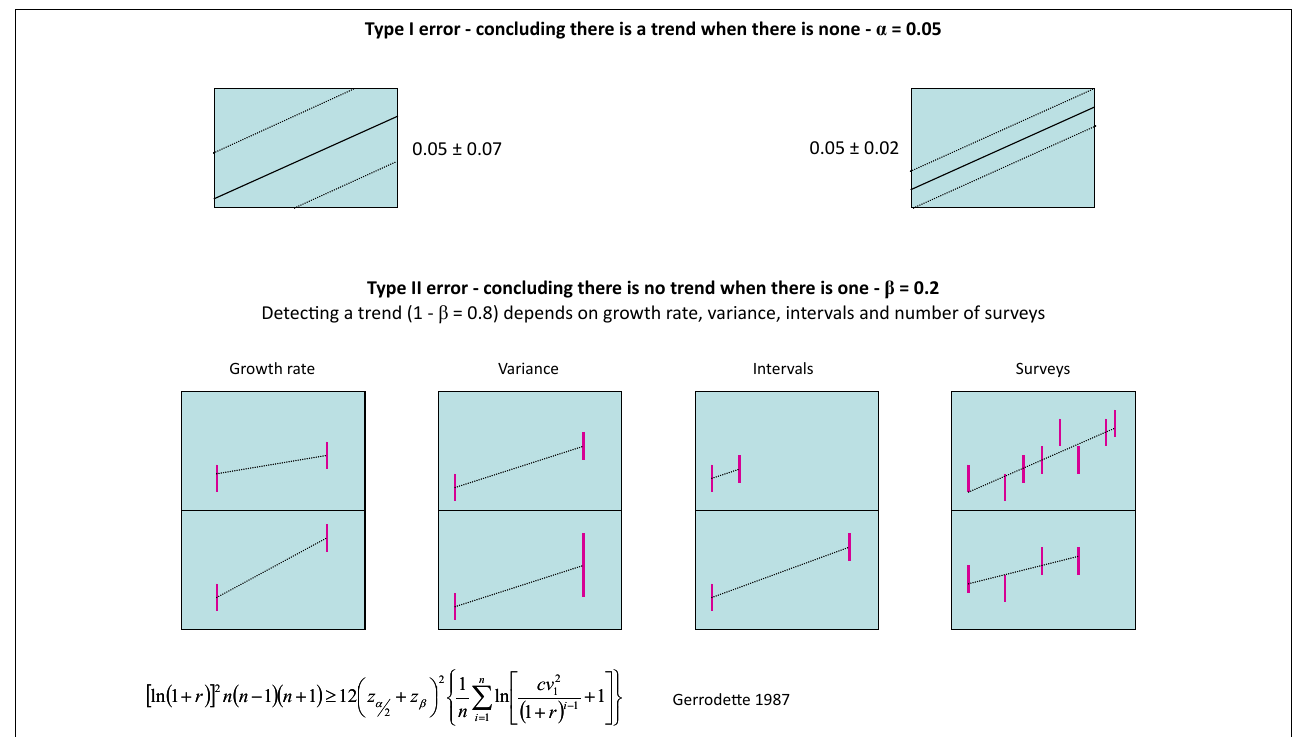
FIGURE 4 : Detecting population trends are constrained by Type I and Type II errors. Researchers traditionally accommodate Type I errors and usually conclude that there is no trend when α > 0.05. However, Type II errors may have as important consequences. For example, a researcher may conclude that there is no declining trend when α > 0.05 for a threatened species, when, in fact, there was a high probability for a Type II error, which may ultimately lead to local extinction. The power to detect a trend carries several trade-offs illustrated in the diagram. This includes the magnitude of the trend to be detected, the variance of population estimates, the intervals between surveys and the number of surveys (Gerrodette, T., 1987, ‘A power analysis for detecting trends’, Ecology 68, 1364–1372.